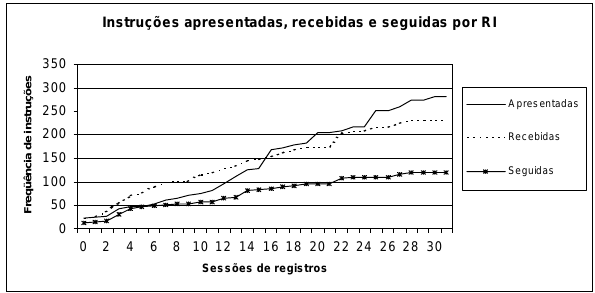
Figura 3 . Freqüência acumulada de instruções apresentadas, recebidas e seguidas por RI no período de Levantamento de Repertório de Entrada (sessão 0) e ao longo das 31 sessões de registro de coleta de dados.